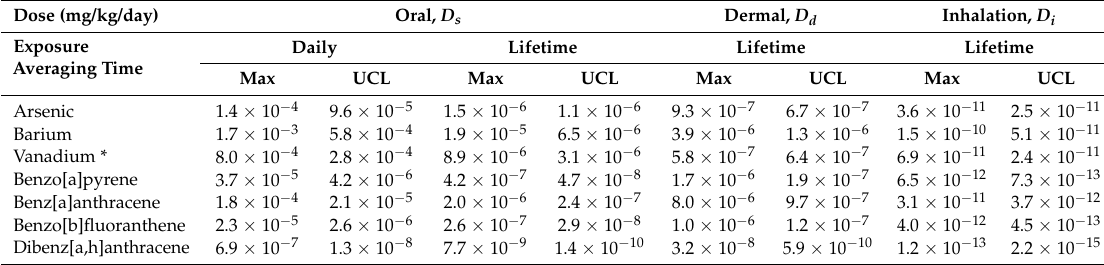
Table 5. Dose in units of milligrams of chemical per kilogram body weight per day computed for chemicals of concern for daily (non-cancer endpoint) and lifetime (cancer endpoint) exposures. Routes evaluated included oral, dermal and inhalation. Concentrations used include the maximum value and the 95% UCL.